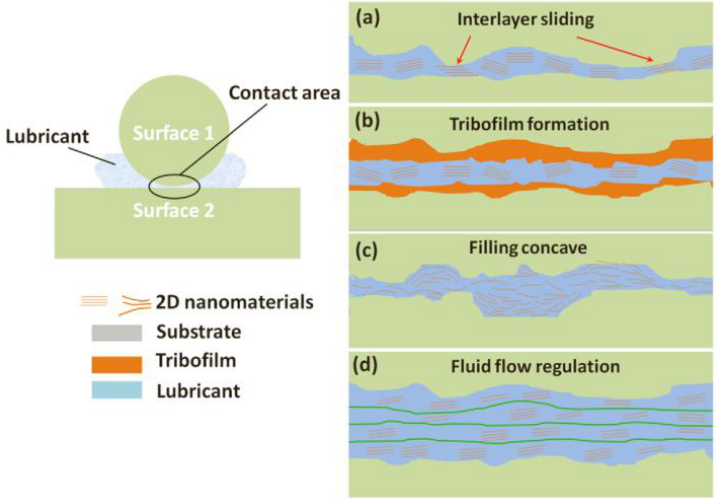
Figure 1. Anti-friction and anti-wear mechanisms of 2D materials. ( a ) entering the contact area of sliding surfaces, ( b ) tribofilm forming, ( c ) filling the pits and gaps of contact area, ( d ) affecting the fluid drag and viscosity. Reproduced with permission from reference Xiao et al. [39], Copyright 2017, Elsevier.